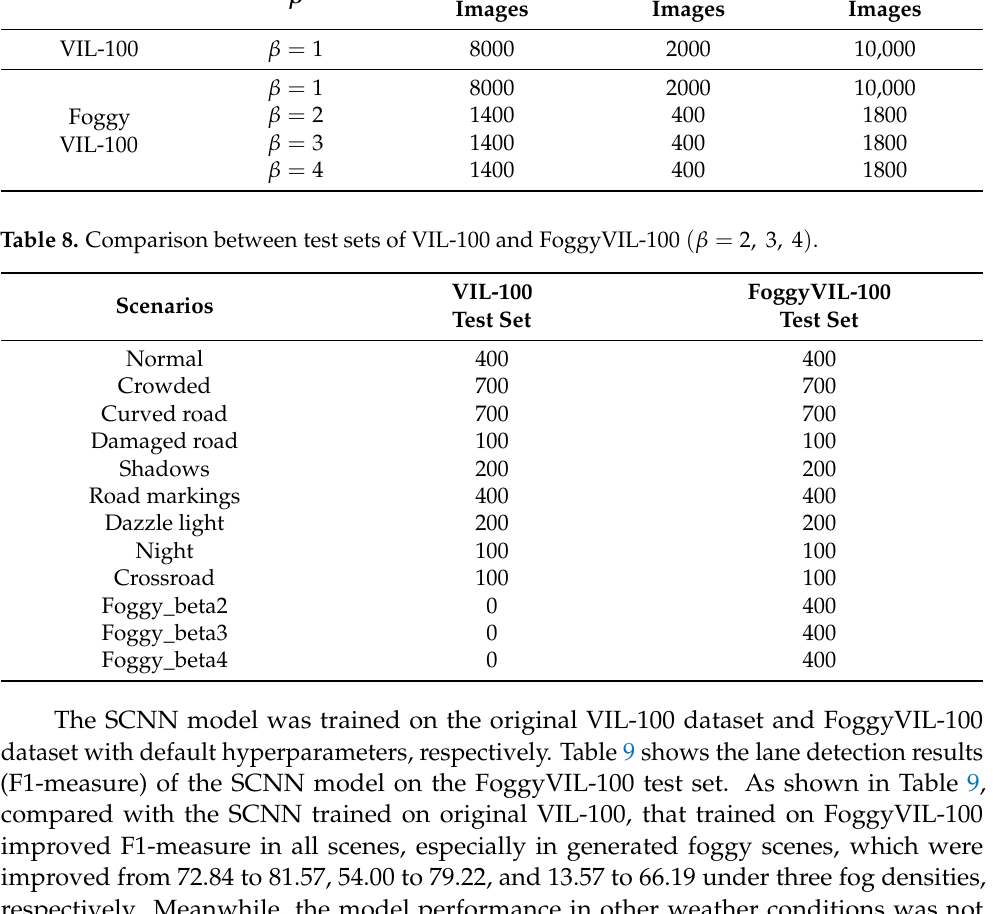
Table 7. The overall file structure of the FoggyVIL-100 dataset compared with the original VIL-100 dataset, β is set to 2, 3, and 4 for simulated fog, and β = 1 represents the original clear image. Train Set β